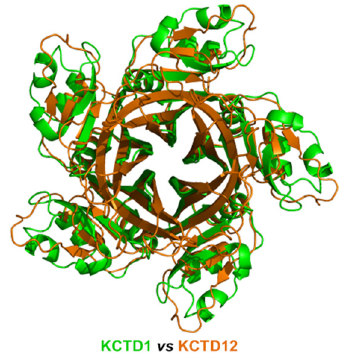
Figure 2. Structural superimposition of the CTD domains of KCTD1 (green) and KCTD12 (orange) obtained by combining US-align and PyMOL (see Section 4). The RMSD value computed on the C α atoms (325 atoms aligned) is 2.48 Å.